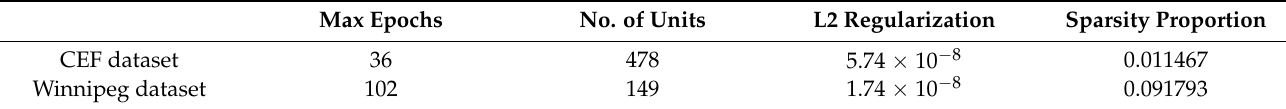
Table 3. Optimized parameters for each